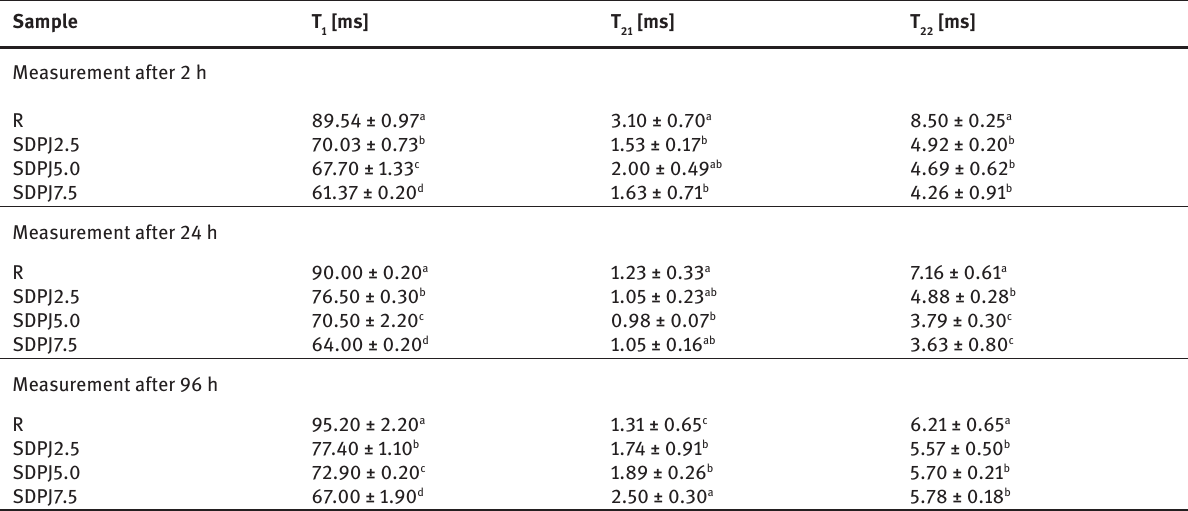
Table 1: The NMR relaxometry measurement results